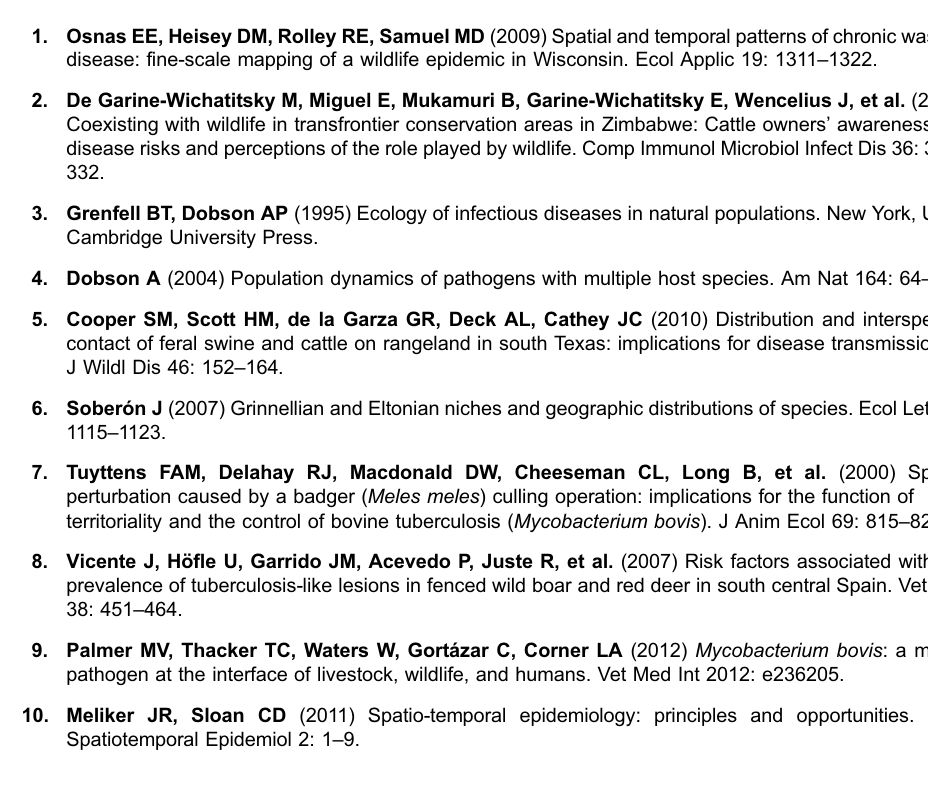
S2 Fig. High-resolution image obtained from UAS camera. High-resolution image obtained from Unmaned Aircraft System camera. Domestic and wild ungulates aggregated in the dry marshland of Don˜ana National Park are observed. S1 Table. Results of abundance models. Results of the generalised lineal models (negative binomial error distribution and logarithmic link function) used to predict red deer, fallow deer and cattle abundance on a spatial scale in Don˜ana National Park. Statistical parameters, coefficients (test-value), are shown for the best-fitting models (in bold). Variable codes are described in Table 1. Measures for model support (Akaike’s information criterion; AIC and D AIC) are included. doi:10.1371/journal.pone.0115608.s003 (DOCX) S1 File. Datasets of TB-tested animals and predicted